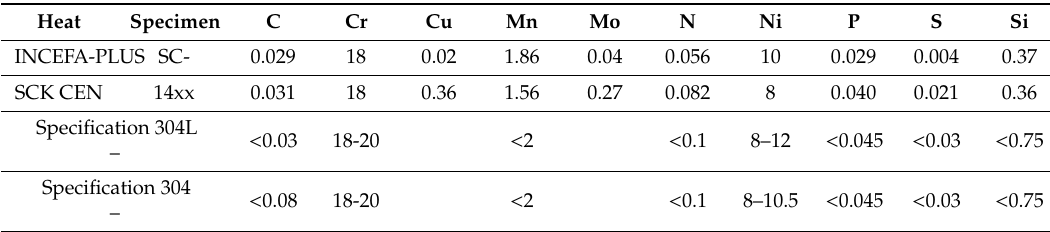
Table 1. Chemical composition of the AISI 304 material